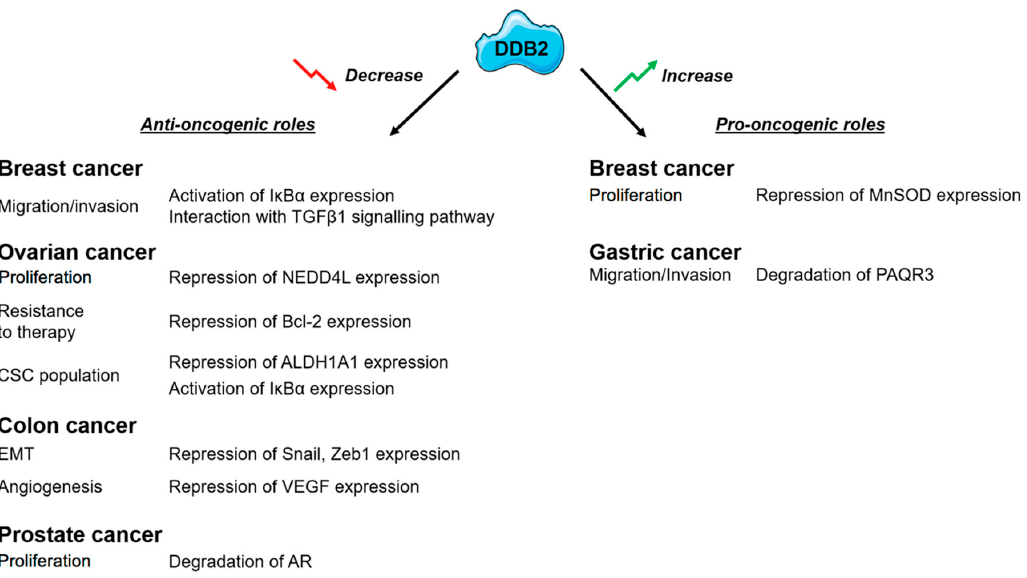
Figure 3. Identified impacts of the DDB2 protein activity in different solid tumors.